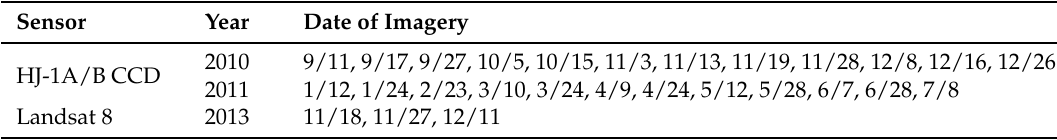
Table 2. Landsat 8 and HJ-1A/B images used in this study.